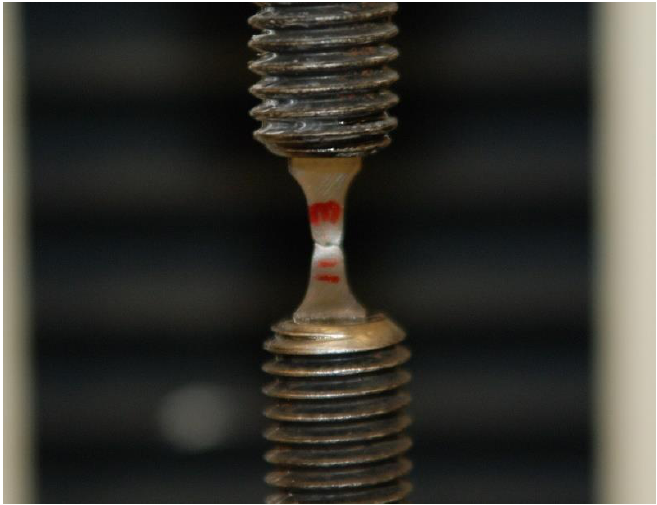
Figure 7. Mini-tensile test specimen during tensile test. The top and bottom screws have the channel parallel to the image plane where sample shoulders were glued. The necking and later fracture can be easily observed.